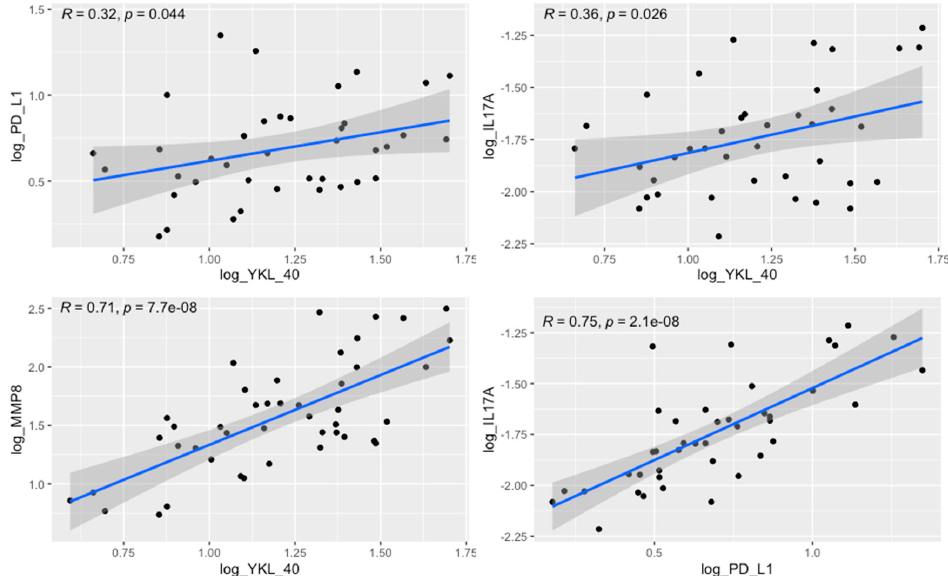
Figure 6. Correlation between the tumor levels of YKL-40 and PD-L1 (R = 0.32, p = 0.044), YKL-40